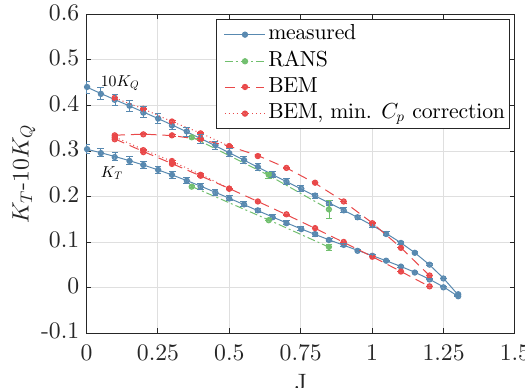
Figure 5. Measured and calculated open water diagrams of the bronze (rigid)